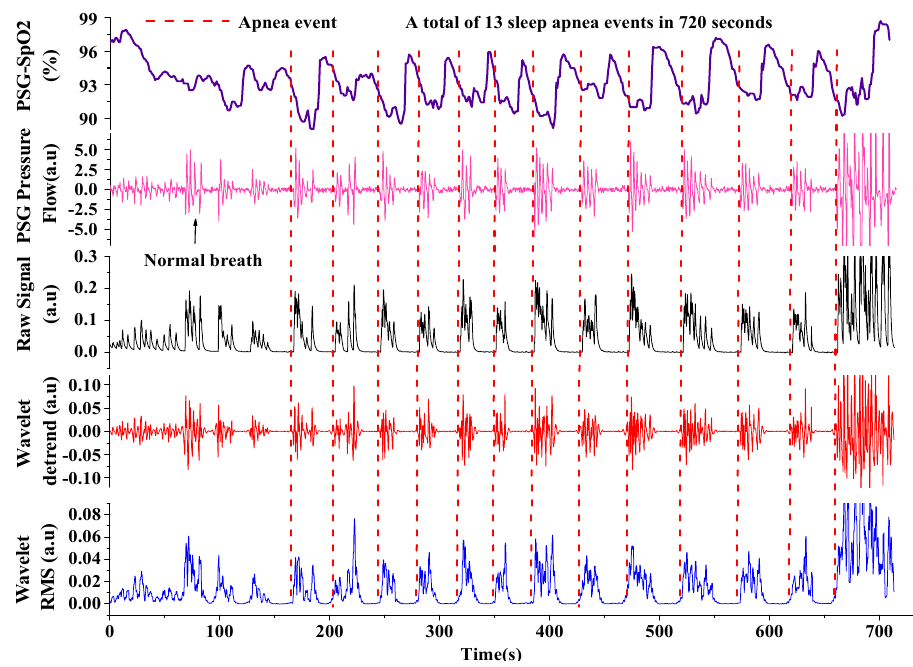
Figure 9. Identification of apnea-hypopnea events from respiratory signals by the wavelet algorithm.